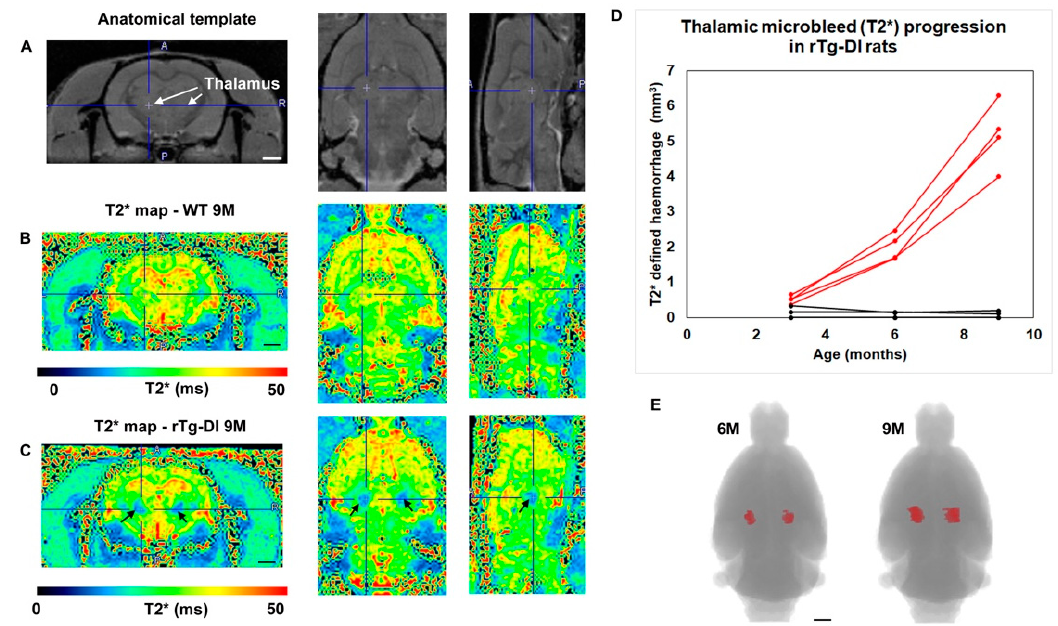
Figure 3. Microbleed progression in thalamus of rTg-DI rats over nine months visualized by MRI. Female rTg-DI CAA rats and wild-type rats were scanned longitudinally at 3, 6 and 9 months of age to track development of microbleeds as defined by T2* parametric mapping in rTg-DI rats. ( A ) Proton density weighted (PDW) anatomical MRIs presented in three orthogonal planes from a 3-month old rTg-DI CAA for demonstrating the position of the thalamus (white arrows) where the presence of microbleeds is typically noted. ( B ) T2* parametric, color coded images of the brain presented in three orthogonal planes from a 9 months of age wild type rat. The ‘blue’ and ‘red’ colors represent low and high T2* values, respectively. ( C ) T2* brain map from a 9 M old rTg-DI rat in the same orthogonal planes as in B, with black arrows pointing towards large, dark blue areas in the thalamus representing low T2* ( ≤ 20 ms) values indicating the presence of ferritin (hemorrhage). Note that the location of the thalamic microbleeds is symmetrical. ( D ) Quantitative assessment of thalamic microhemorrhage progression over time as defined by T2* ≤ 20 ms from four different rTg-DI CAA rats (red) in comparison to four wild-type rats (black). Small hemorrhages start emerging at 6 months (but not at 3 months) and continue to expand to nine months (on average a three-fold increase in volume). ( E ) 3D volume rendering of the microbleed in a rTg-DI rat based on T2* ≤ 20 ms, showing the expansion of the microhemorrhage area over time. Scale bars = 3 mm.